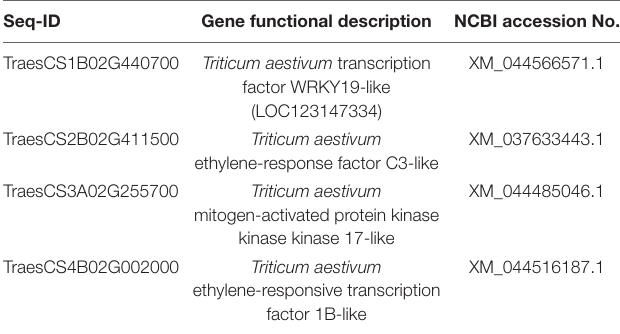
TABLE 4 | Identification of DEGs involved in the key pathway by comparing Piri + Fg vs. Fg. Seq-ID Gene functional description NCBI accession No.